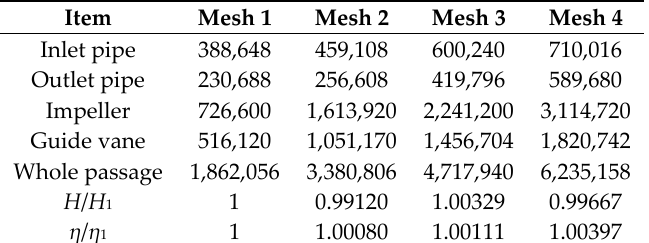
Table 2. Pump head H and efficiency η versus mesh elements.